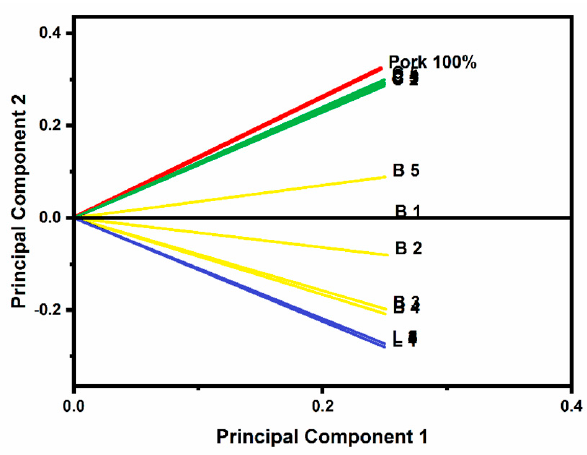
Figure 5. Principal component analysis plot showing the similarity between pork, chicken, lamb, and beef samples with adulterated mixtures. C1–C5 (10–50% Pork), B1–B5 (10–50% Pork), L1–L5 (10–50% Pork). Table 6. Percentage of variance for each PCA component contributing to the variation of the classification.